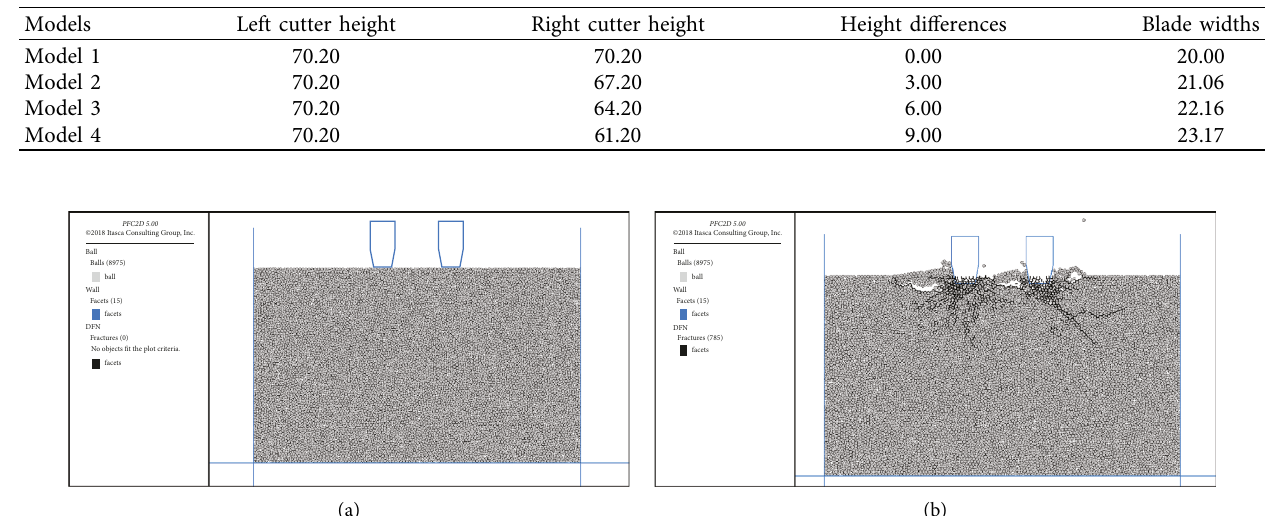
Table 3: Disc cutter parameters of models (unit: mm).